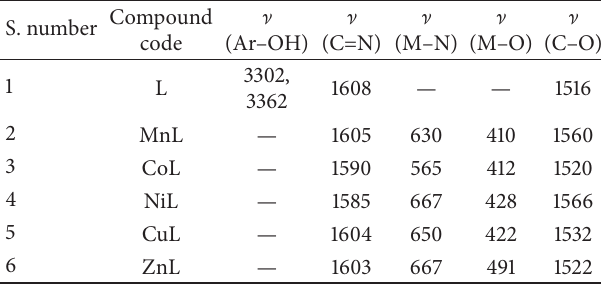
Table 2: Infrared absorption frequencies (cm − 1 ) of ligand and its polymeric complexes. Compound S. number code